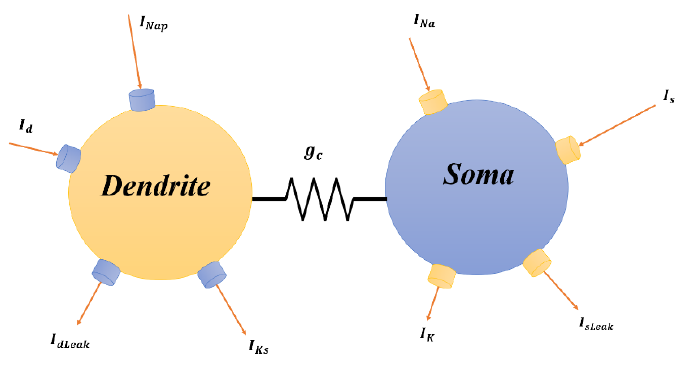
Figure 1. Two-compartmental Pinsky–Rinzel model of CA 3 neurons.